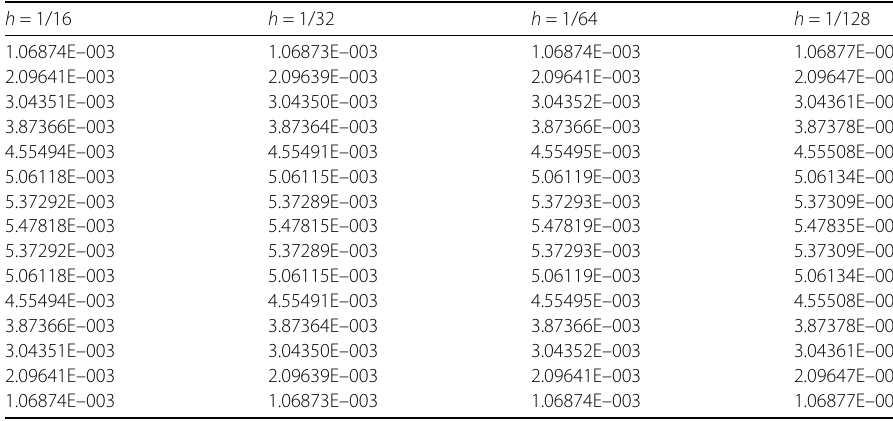
Table 1 Solutions on the line y = 0 of Problem 1